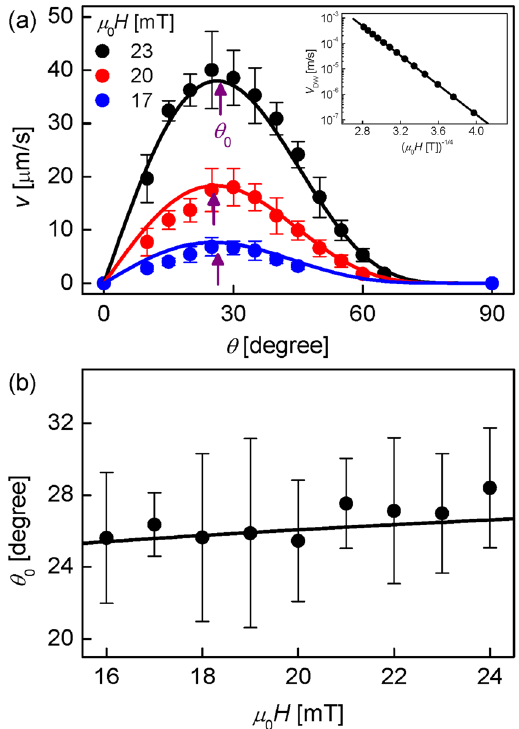
Figure 2. Angle dependence of magnetic bubble motion. ( a ) Measured v with respect to θ for several H (symbols). The solid lines are best fits with Eq. (1). The purple arrow represents θ 0 . The inset plots the DW speed V DW (i.e. the bubble expansion speed) with respect to the purely out-of-plane magnetic field (i.e. θ = 0). The error bars are obtained by the standard deviation of more than 20 times repeated measurements. ( b ) θ 0 with respect to H . The solid line is the numerical evaluation of Eq. (3) with the experimental value of α 0 ( = 6.7 T 1/4 ). The error bars are obtained by the root-mean-square error of the parabolic